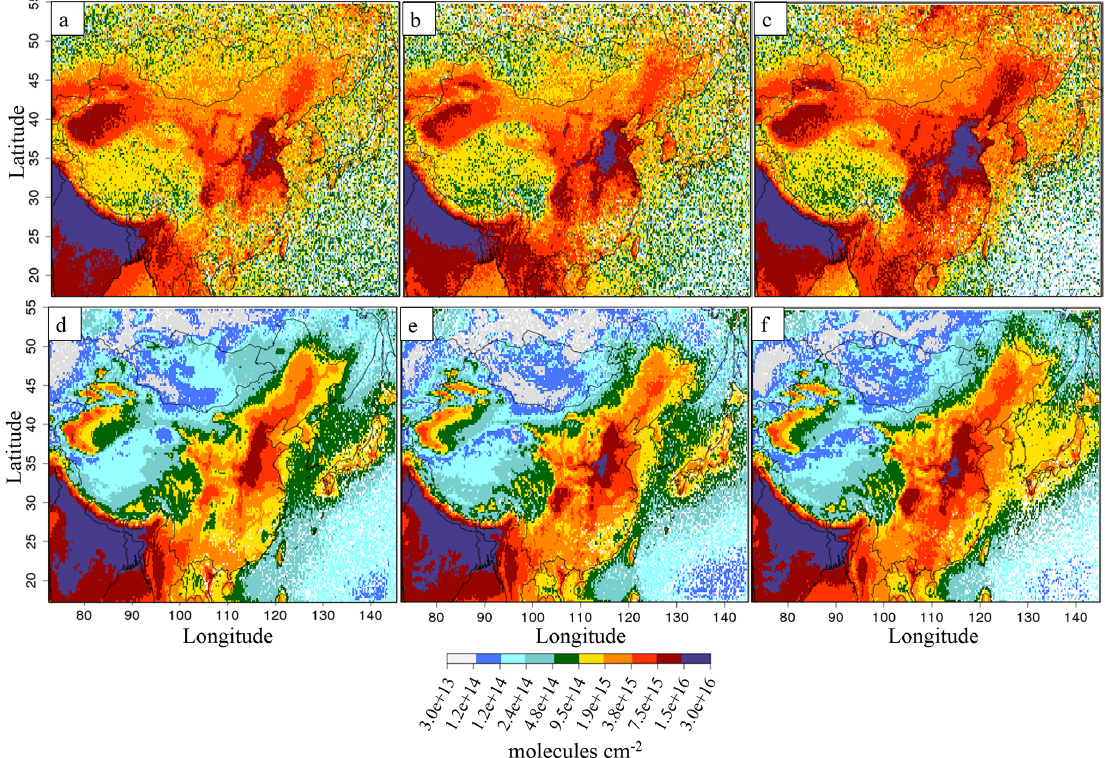
Figure 12. Ammonia column evolution for IASI (a, b, c) and CHIMERE (d, e, f) in (a) 2011, (b) 2013, (c) 2015, (d) 2011A, (e) 2013C and (f) 2015C (moleculescm − 2